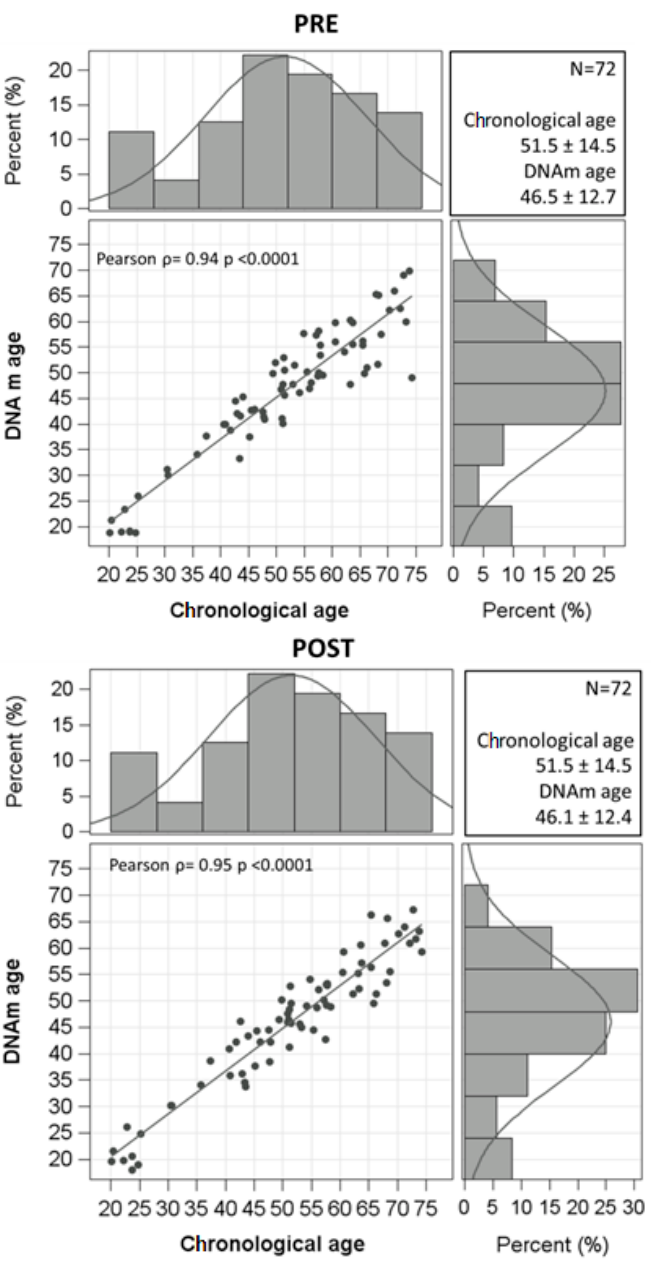
Figure 1. Distribution of chronological age and DNA methylation (DNAm) age. Scatterplots and Pearson’s correlation coefficients for chronological age and DNAm age (estimated by Zbiec–Piekarska formula, pre- and post-BWRP) are reported.